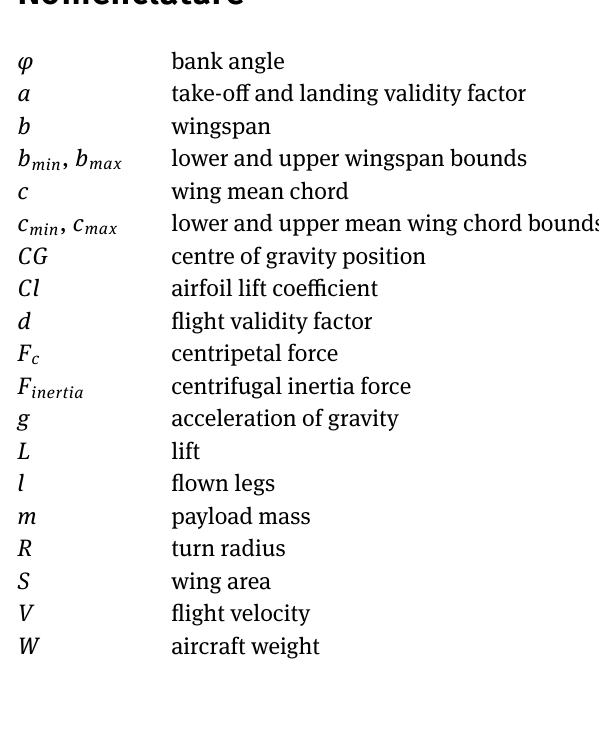
Figure 14: Flight score (points) as per Equation (1) as a function of wingspan and wing mean